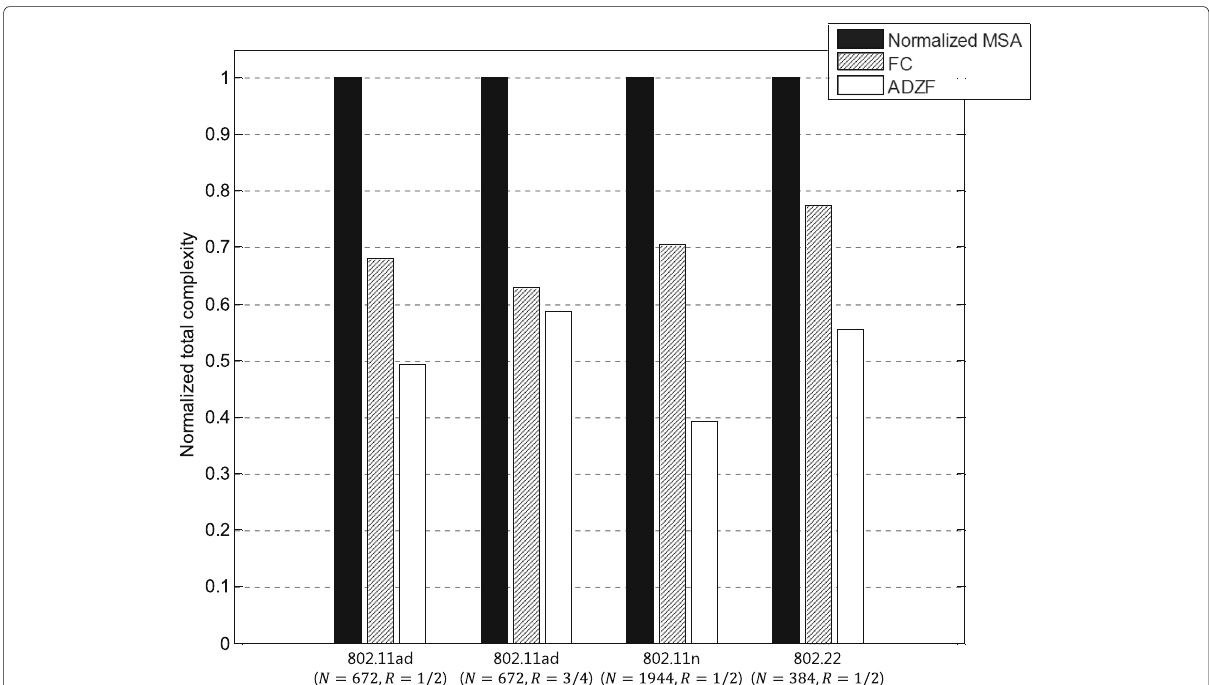
Fig. 17 Normalized total complexity of normalized min-sum algorithm, conventional FC scheme, and the proposed algorithm (ADZF) when FER = 10 −